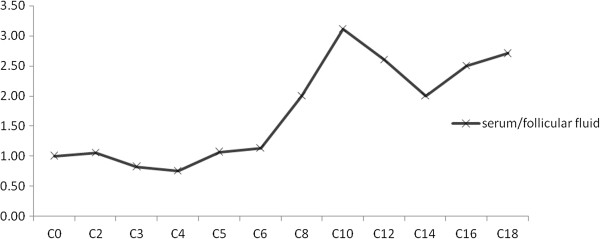
Serum to follicular fluid ratio of individual acylcarnitines. Serum to follicular fluid ratio of individual acylcarnitines as a function of the carbon chain length of acylesters.